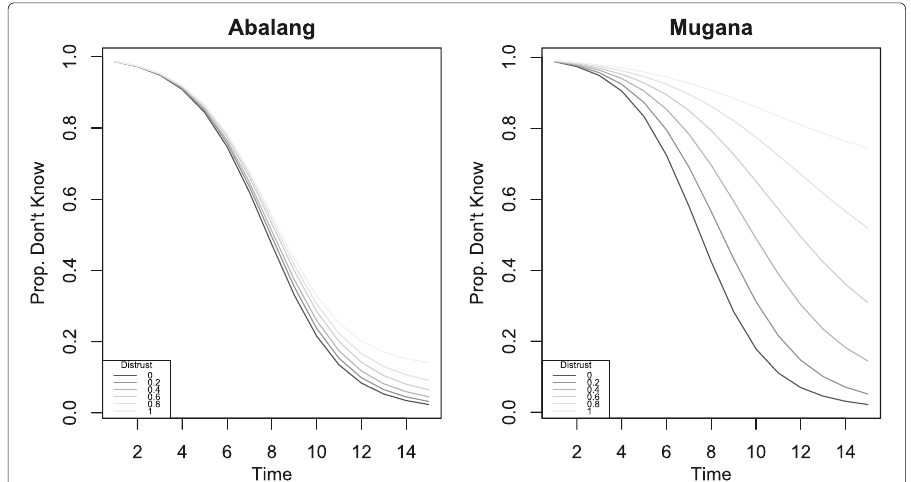
Fig. 1 Proportion of network that remains uninformed by each timestep in simulated information spread on two real social networks, taking ethnic group as the relevant type. Simulation parameters set to x = 2, p strong = 1, and p weak = { 0,.2,.4,.6,.8,1 } . Legend displays Distrust = 1 − p weak . The lower the capacity of